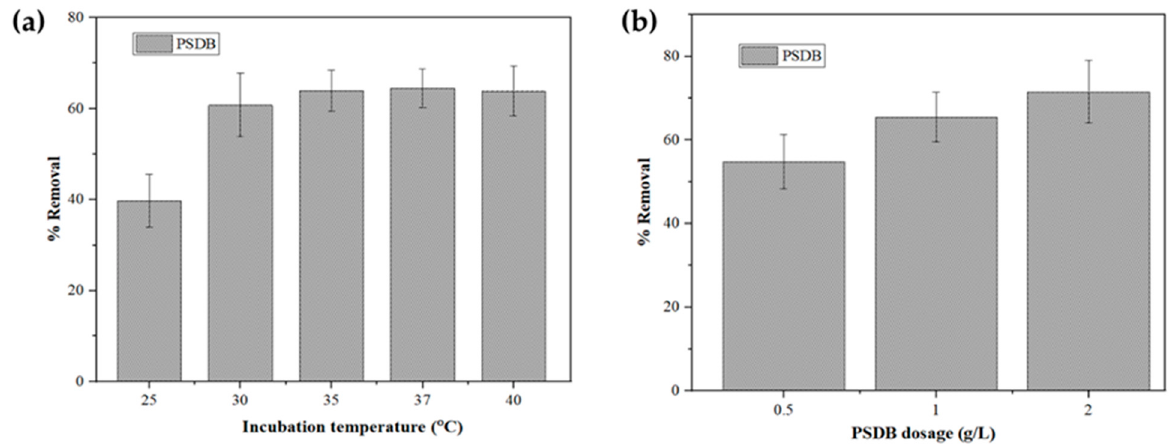
Figure 7. Ni removal by PSDB; ( a ) effect of incubation temperature; ( b ) effect of PSDB dosage.